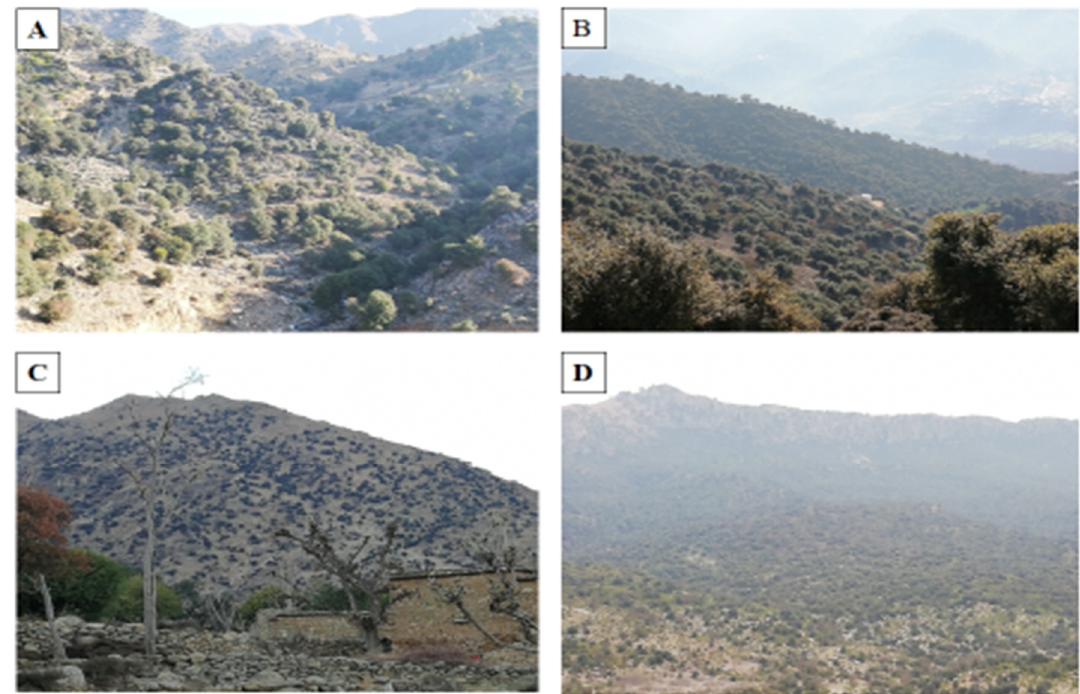
Figure 3. Monotheca forests at different locations in the study area, ( A ). Dir District, ( B ). Malakand District, ( C ). Bajaur District, ( D ). Musakhel District.